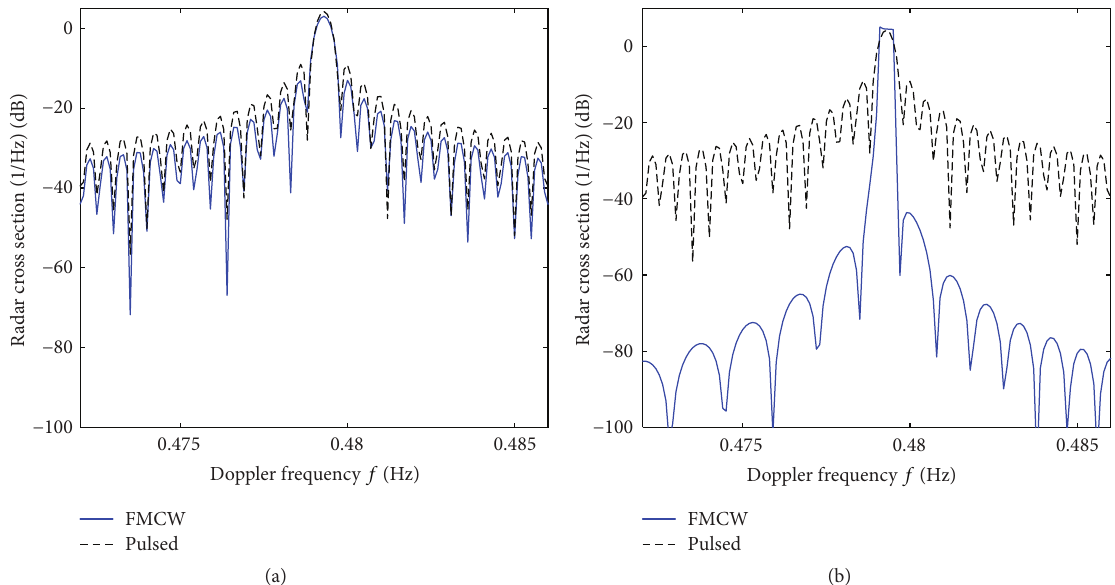
Figure 3: Comparison of the side lobe levels of the first-order radar cross sections for the pulsed and FMCW waveform. (a) Δ𝑟 = 0.5Δ𝜌 and (b) Δ𝑟 = 10Δ𝜌